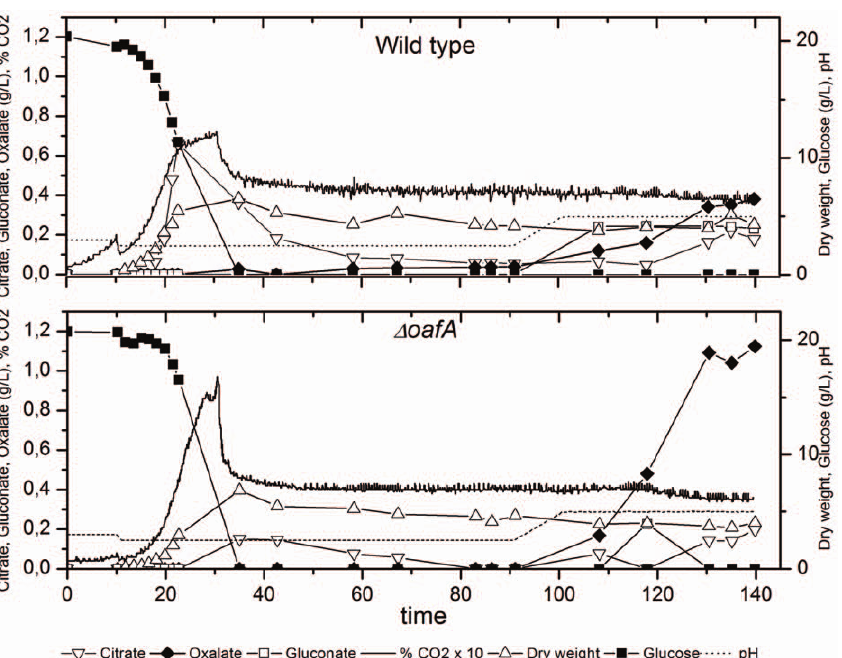
Figure 3. Representative profiles of chemostat cultivations for wild type (top) and D oafA (bottom). Two steady states were obtained for each chemostat cultivation performed.